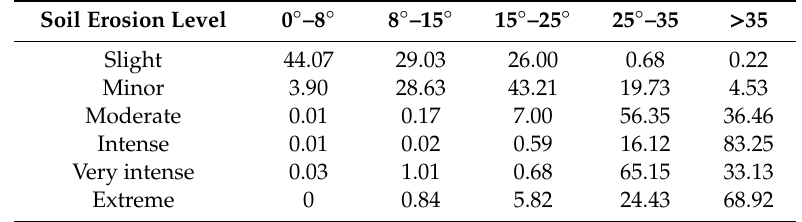
Table 5. Statistical information for the area percentage of soil erosion at di ff erent slopes